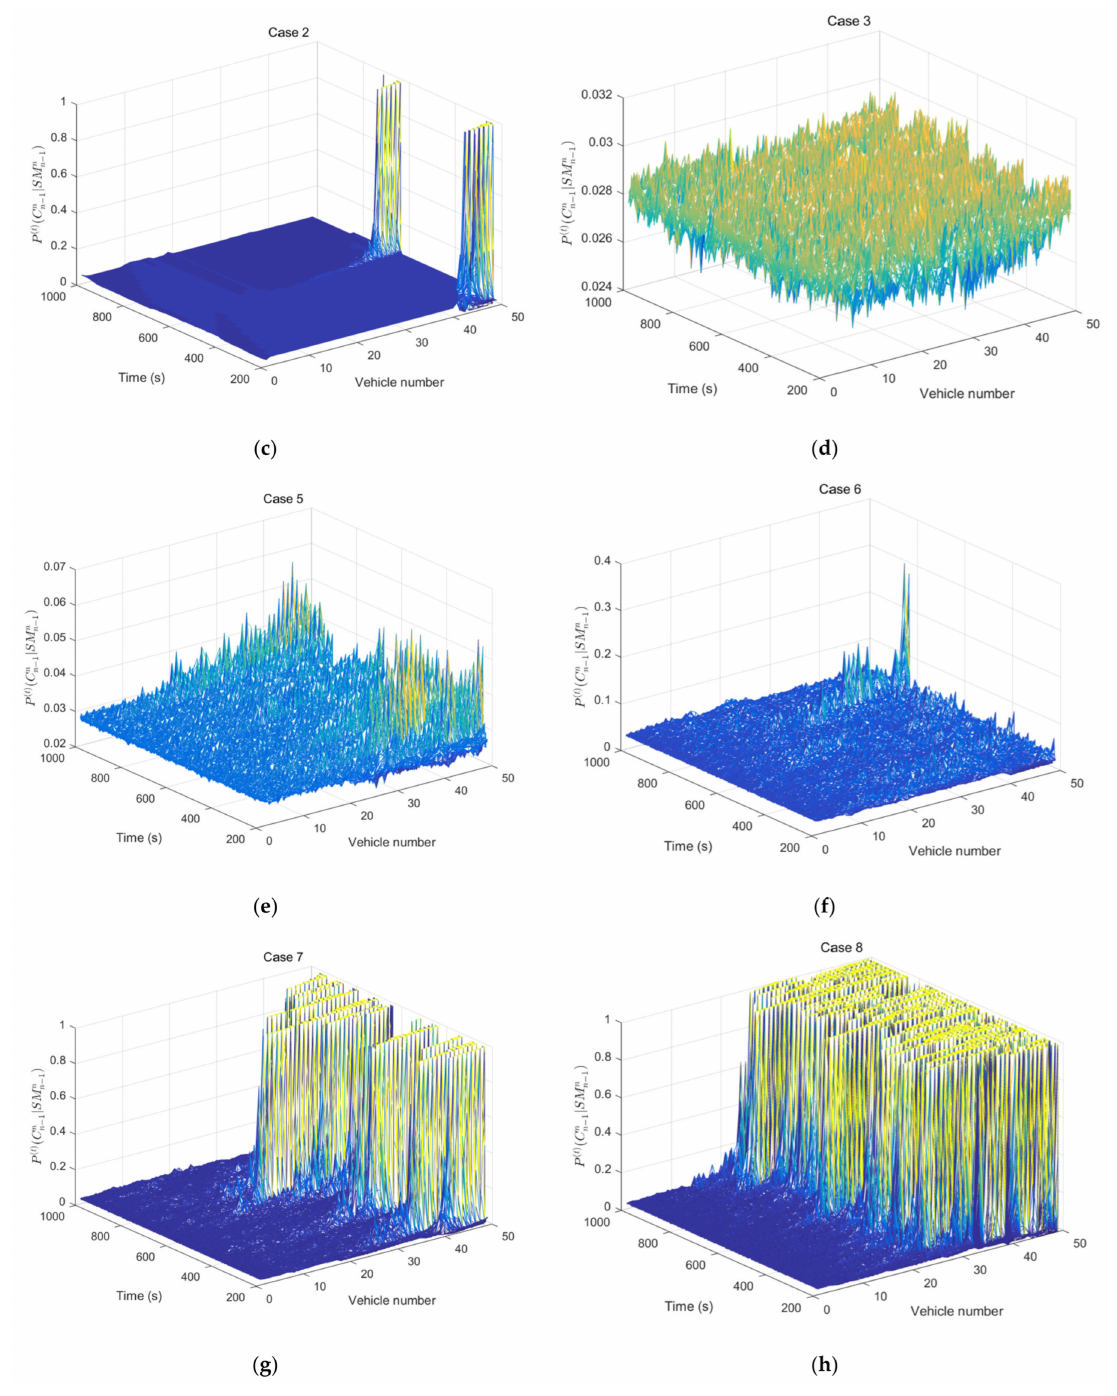
Figure 8. REC probability patterns of all other cars (except the leading car) under different